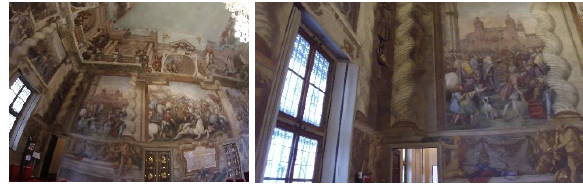
Figure 12. Comparison of video frames and FOV for the ZebCAM (left) and Osmo+ DJI (right) extracted for photogrammetric purposes.